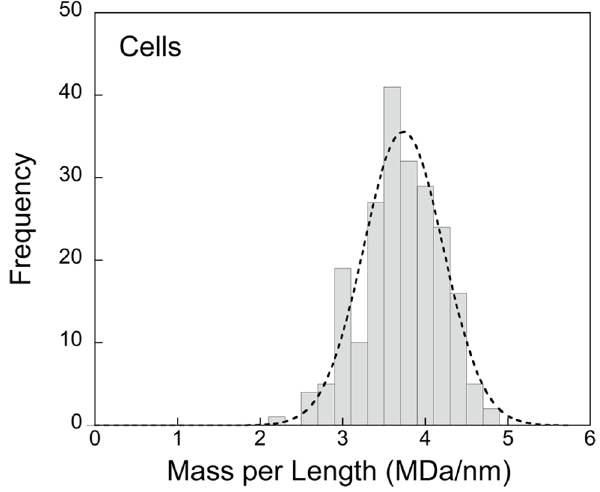
Figure 3. Histogram of the mass-per-length distribution in MDa/nm for a Spiroplasma cell population. The Gaussian (r 2 =0.97) fit superimposed on the histogram implies a normal distribution. The average mass is 3.74 6 0.68 (SD) MDa/nm. The mass of an average cell is 22.2 GDa.